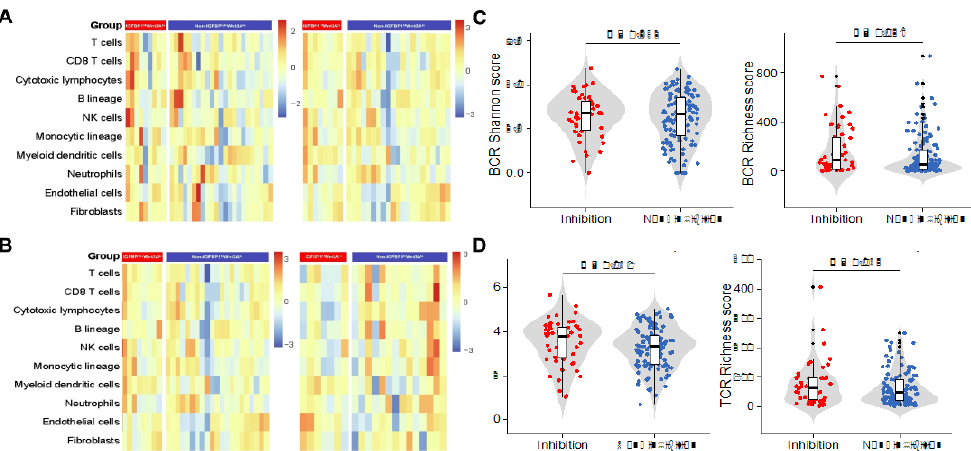
Figure 6. Immune cell infiltration and immunological features. ( A ) Immune cell infiltration in the GSE165252 cohort, shown on the left before immunotherapy and on the right after immunotherapy; ( B ) immune cell infiltration in the GSE165252 cohort and the BJIM cohort, showing the GSE165252 cohort after immunotherapy on the left and the BJIM cohort after immunotherapy on the right; ( C , D ) violin plots of BCR/TCR richness and diversity (Shannon score).